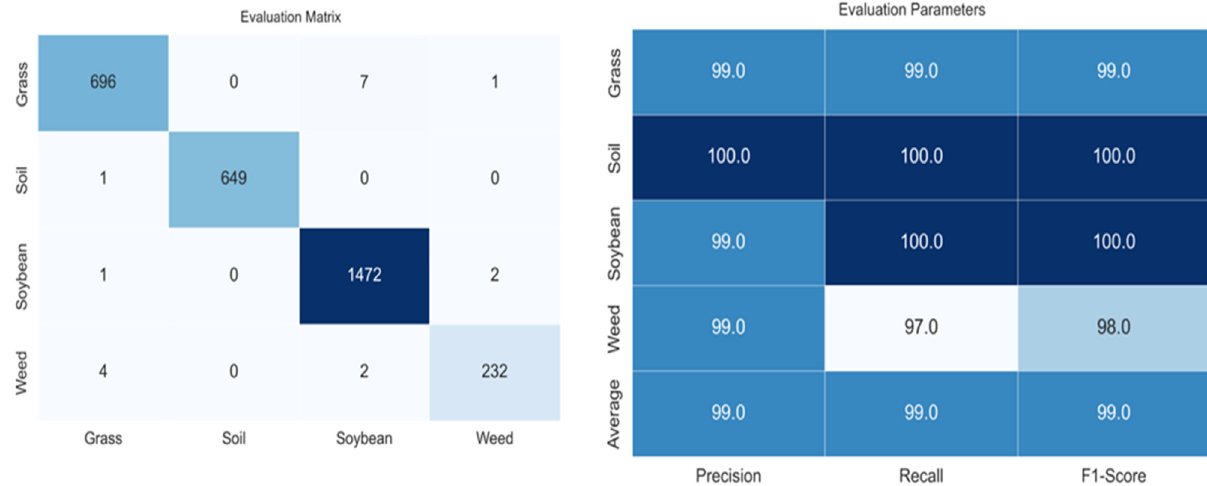
Figure 7: Testing on plain dataset [ 37 ]